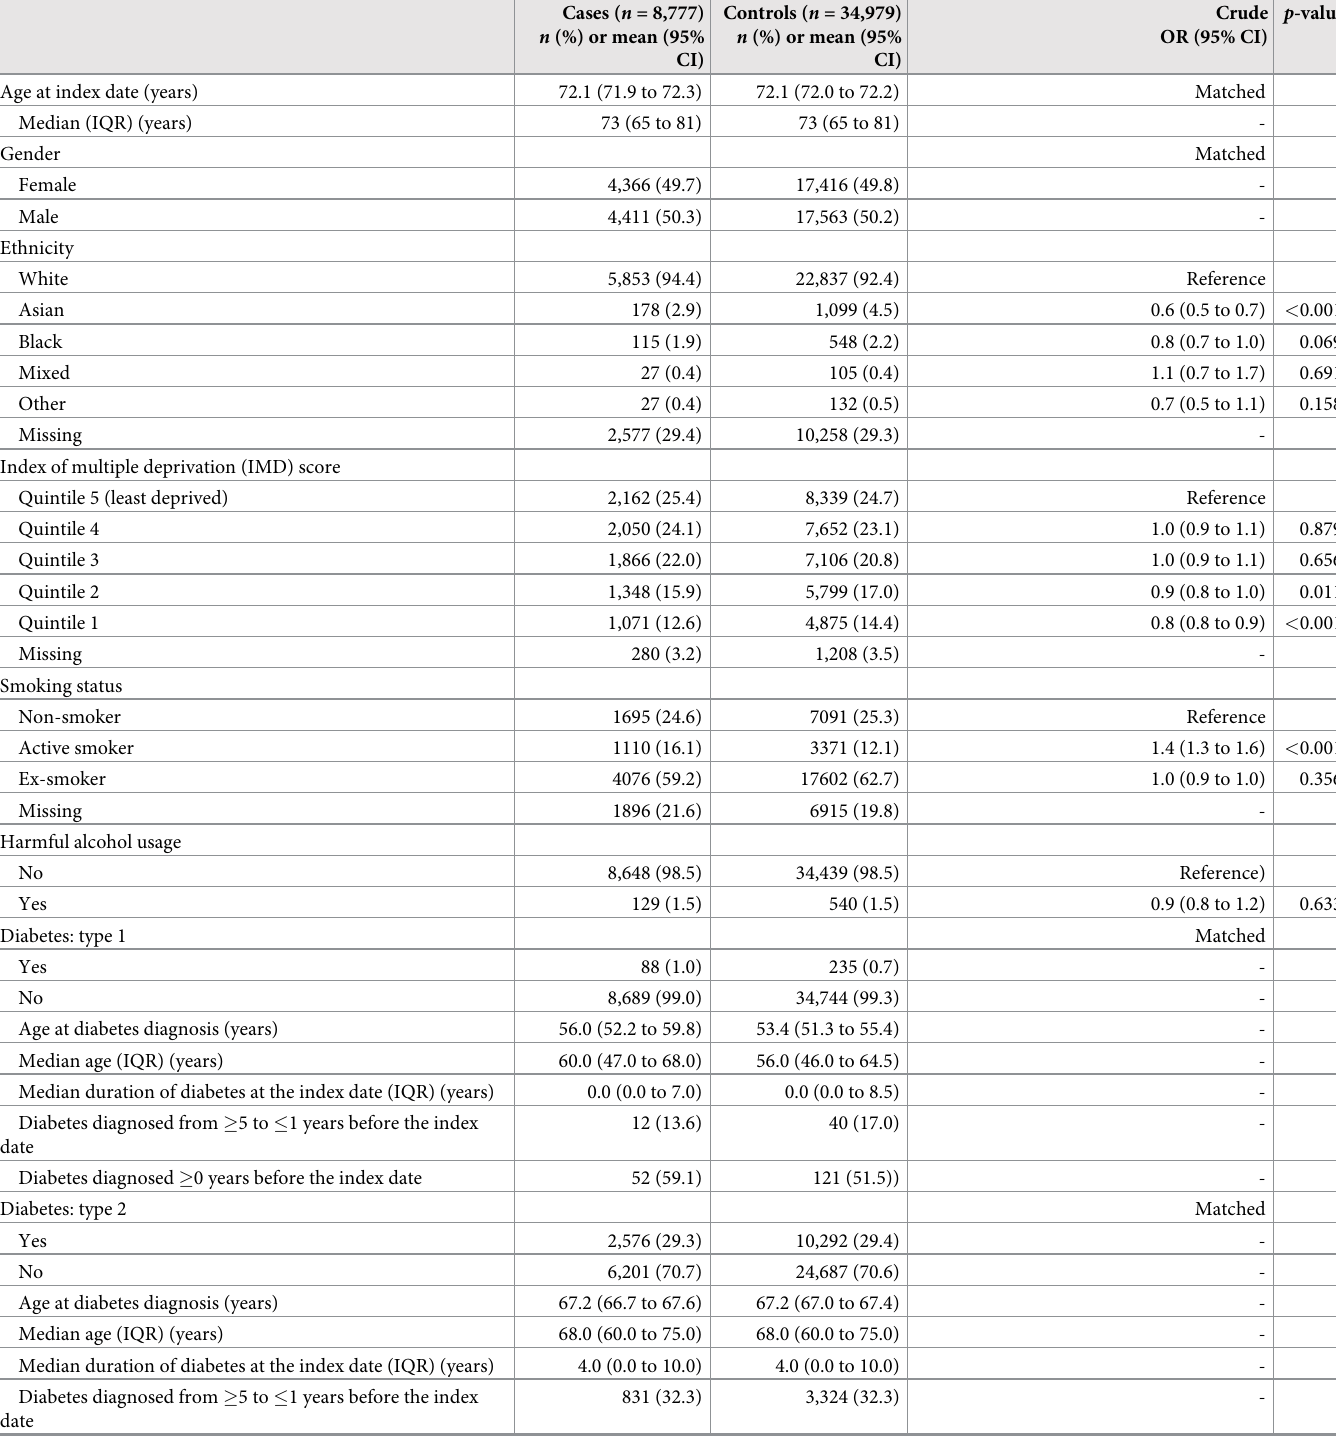
Table 1. Characteristics of the study sample. Comparison of pancreatic cancer cases and controls using crude (unadjusted) odds ratios (OR) and 95% confidence inter- vals (CI) calculated with conditional logistic regression to account for matching on age, gender and diabetes. Subgroup analysis of body mass index (BMI) and